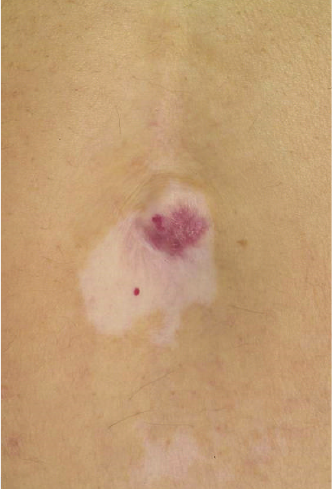
Figure 1: Umbilicus demonstrating vitiligo with overlying lichen planus.